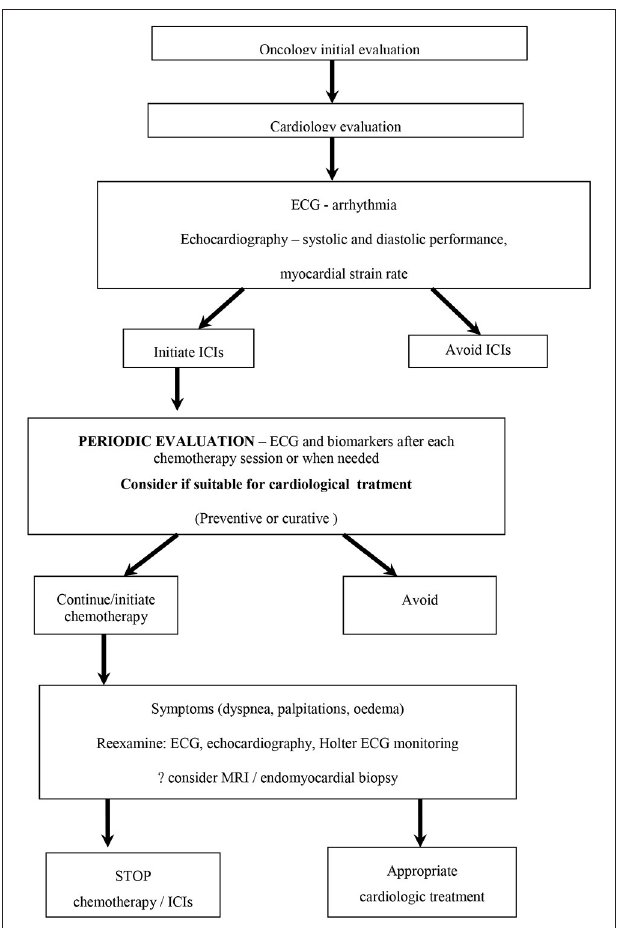
FIGURE 2 | Algorithm for evaluating the patient who will be treated with immune checkpoint inhibitors [adapted after Liu et al. (28)].